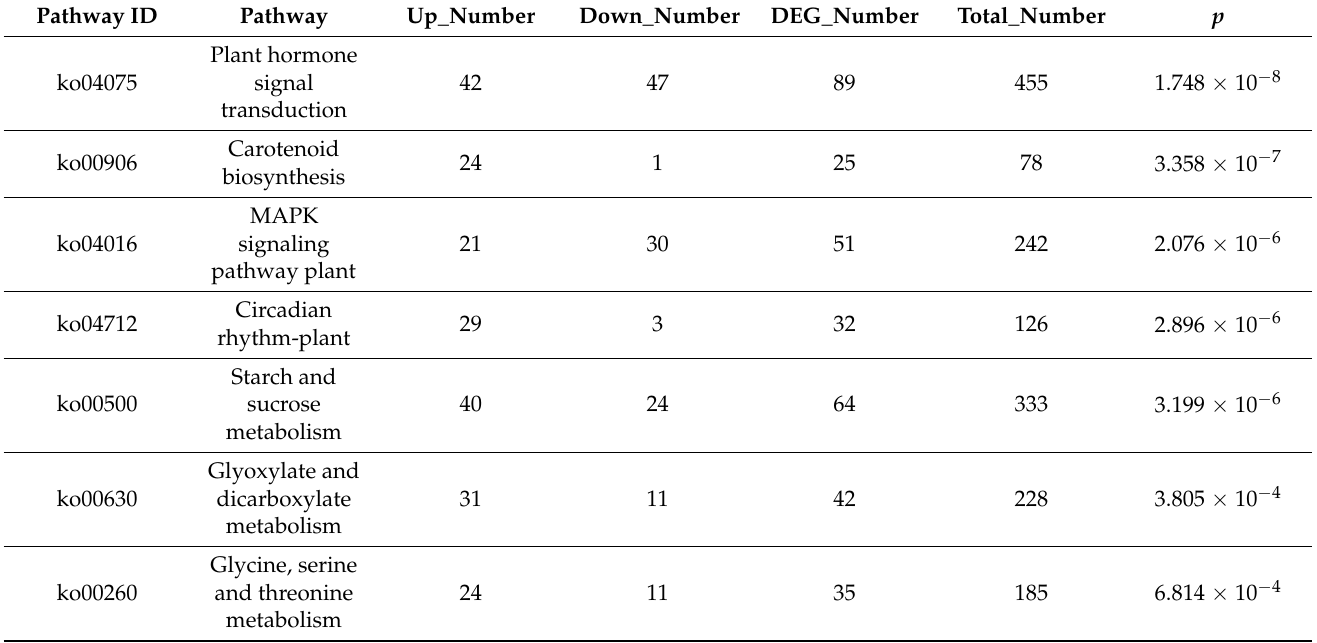
Table 4. KEGG enrichment analysis based on DEGs in the comparison of RACK vs.